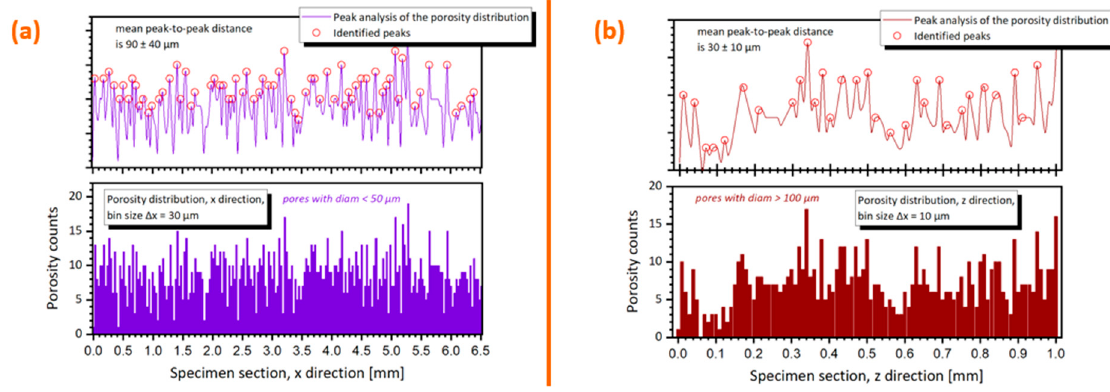
Figure 14. ( a ) Peak analysis porosity distribution along the X direction for the CN2-CuCr1 sample, considering only porosities with Ø cs < 50 µm; ( b ) Peak analysis porosity distribution along the Z direction for the same sample, considering only porosities with Ø cs > 100 µm.